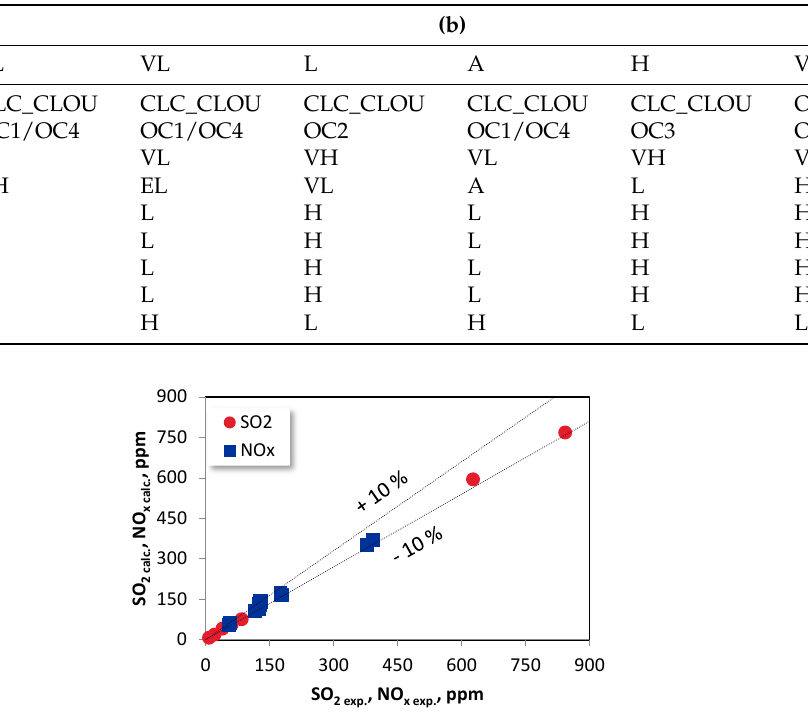
Figure 6. Validation of the model.